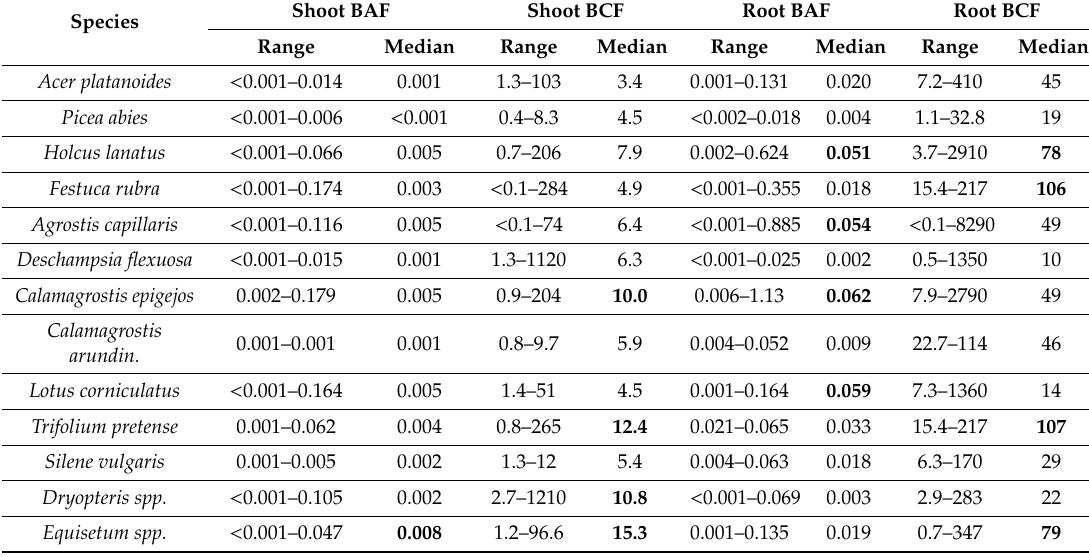
Table 4. Arsenic BAF and BCF values calculated for shoots and roots of particular plant species. BCF related to 1M NH 4 NO 3 -extractable As in